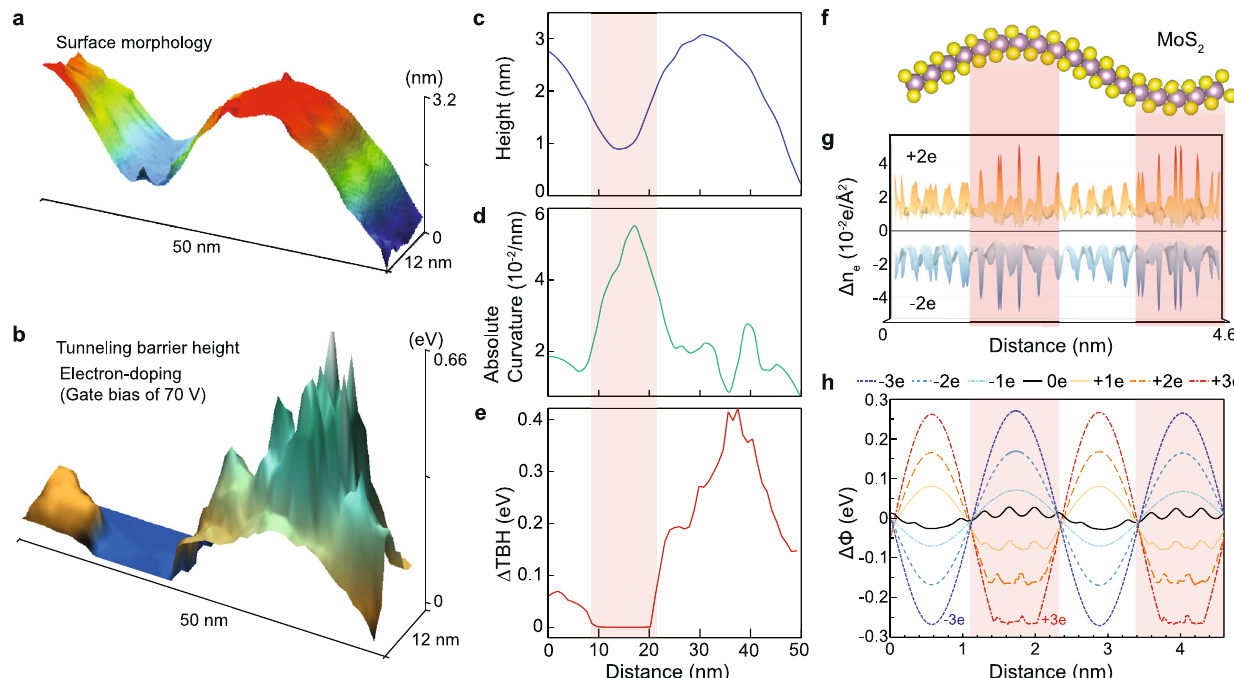
Fig. 3 | Charge localization at a curved MoS2. a STM topography and b TBH mapping at 70V of gate bias as electron-doping. c – e the correlations among the averagedlinepro fi lesof( c )thesurfacemorphology,( d )absolutecurvature,and( e ) relativeTBHdifference( Δ TBH )oftheareashownin( a ).Theaveragevaluesforplots wereobtainedintheaxisof12nmin( a , b ).(SupplementaryFig.7foreachcurvature value)Thesamplebiasof − 3Vwasapplied. f Structuralmodelofcurvedmonolayer